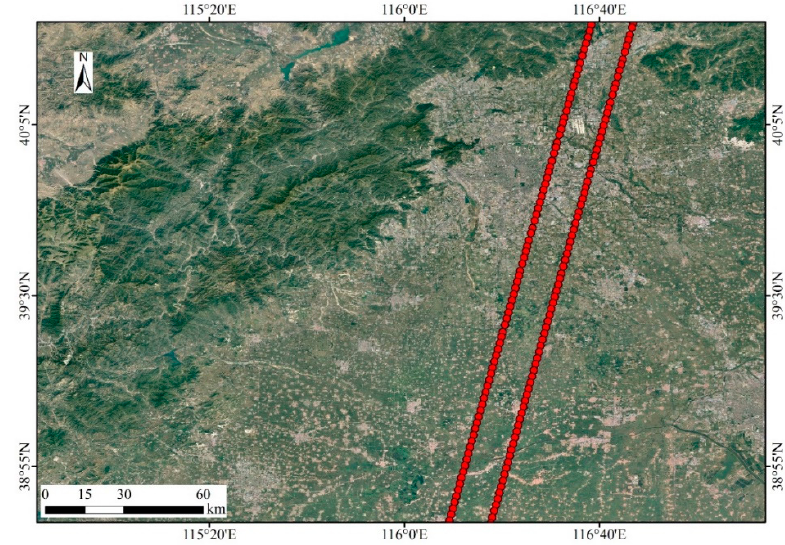
Figure 8. Schematic diagram of typical saturated data acquisition location.